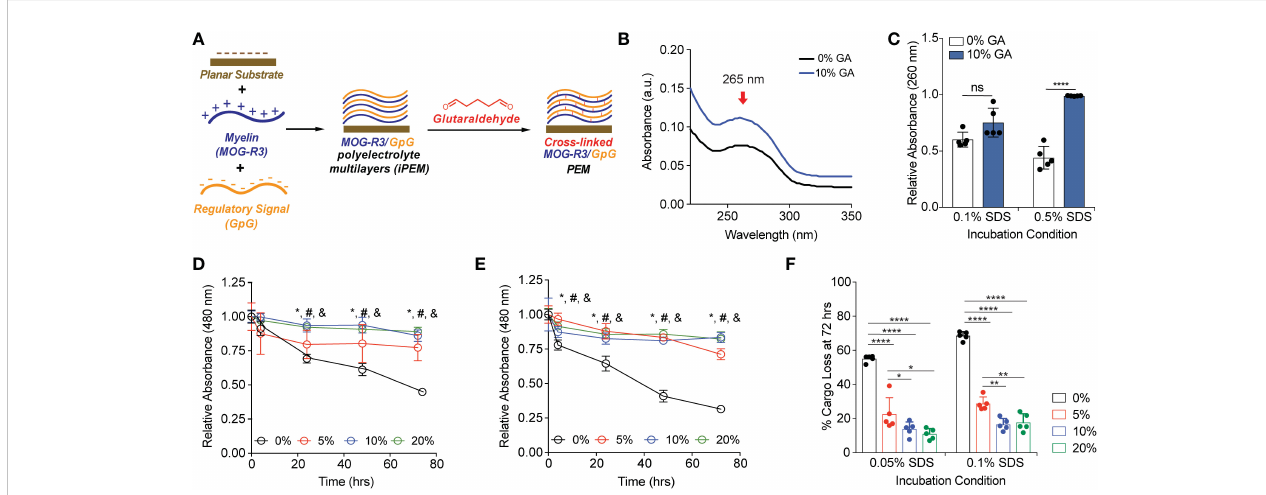
FIGURE 1 Glutaraldehyde mediated cross-links between MOG-R3/GpG biomolecular layers on planar substrates protect against delamination of the cargo in an anionic surfactant. (A) Schematic view of layer-by-layer electrostatic assembly of myelin self-antigen (MOG-R3) and TLR9 antagonist (GpG) on planar substrate, followed by GA mediated crosslinking. (B) UV-vis spectra of MOG/GpG planar substrates cross-linked with 10% GA solution. (C) Spectrophotometric analysis of planar substrates incubated in various SDS conditions for 15 minutes. Data was normalized to t = 0. Statistical analysis performed using two-way ANOVA comparing 0% GA control to 10% GA in each incubation condition followed by Sidak ’ s multiple comparisons tests. Data represents mean ± standard deviation (n = 5). ns, not signi fi cant. (D) Spectrophotometric analysis of planar substrates incubated in 0.05% SDS. (E) Spectrophotometric analysis of planar substrates incubated in 0.1% SDS. Data was normalized to t = 0. Statistical analysis performed using one-way ANOVA comparing 0% GA control to crosslinked substrates at a given time point followed by Dunnett ’ s multiple comparisons tests. Data represents mean ± standard deviation (n = 5). *p < 0.05 between 0% and 5% glutaraldehyde, # p < 0.01 between 0% and 10% GA, and & p < 0.01 between 0% GA and 20% GA. (F) Quanti fi cation of cargo loss at 72 hrs in 0.05% and 0.1% SDS. Data represents mean ± standard deviation (n = 5). ****p < 0.001% between 0% GA and 5, 10, and 20% GA